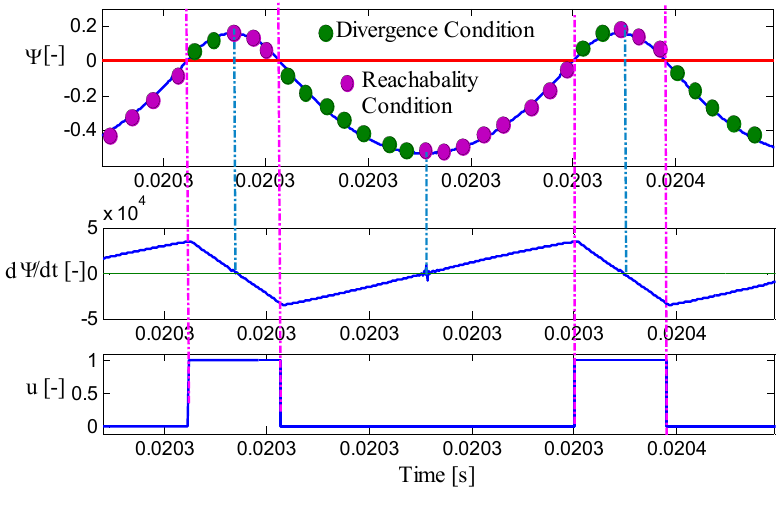
Figure 9. SMC hysteretic behavior.